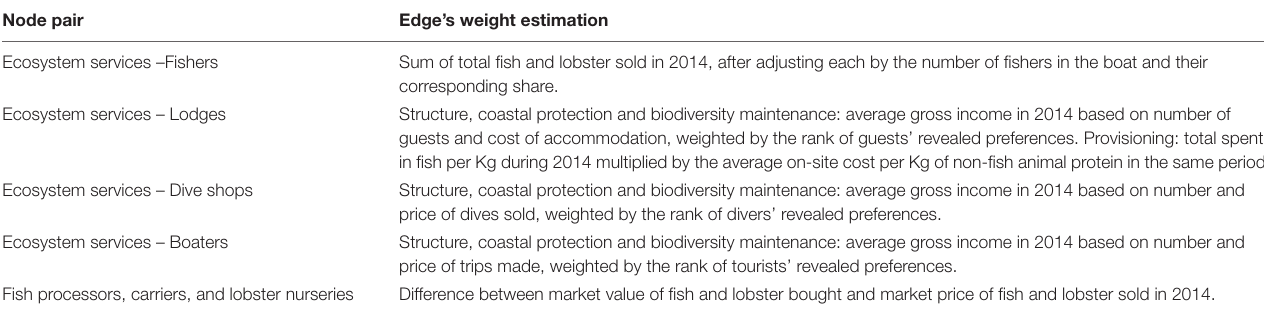
Node pair Edge’s weight